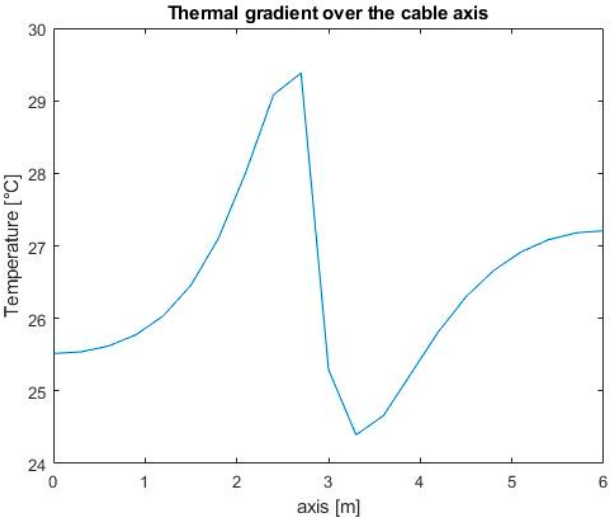
Figure 4. Axial distribution of thermal drop—Scenario E.